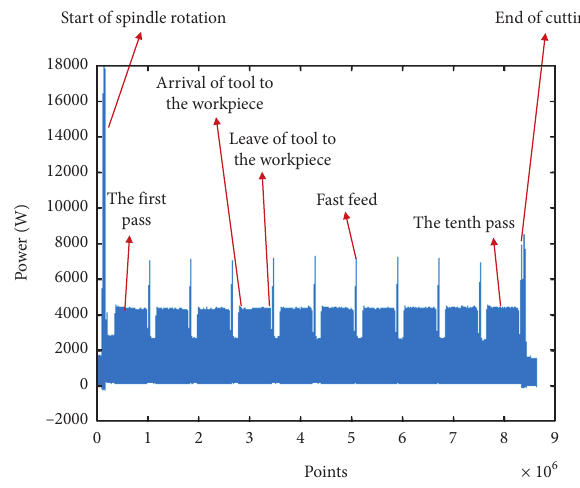
Figure 5: Tool power signal from a cutting Table 2: Controlling parameters during the cutting process. Mill dia. (mm)